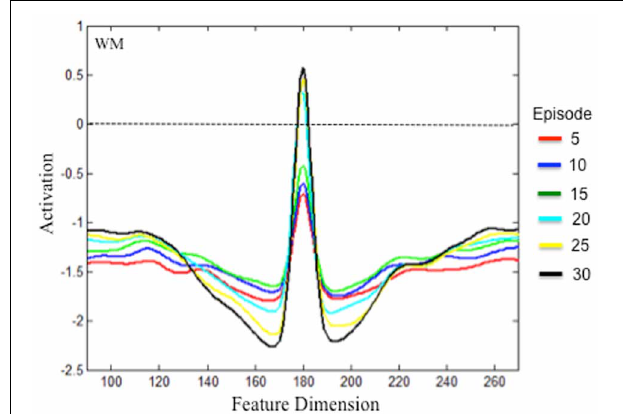
FIGURE 6 | Test results of whether experience accumulated across a dimension can lead to the SPH at the level of neural interaction. The model was initialized with the experience accumulated in the Hebbian layers after every 5 episodes of exploration, which is shown by the different colored lines. The figure shows the state of WM during the inter-stimulus interval following stimulus presentation (see text). With experience, the WM field was able to form a stable peak. This peak had a strong excitatory component and deep inhibitory component much like implementing the SPH via hand-tuning the strength of excitatory and inhibitory